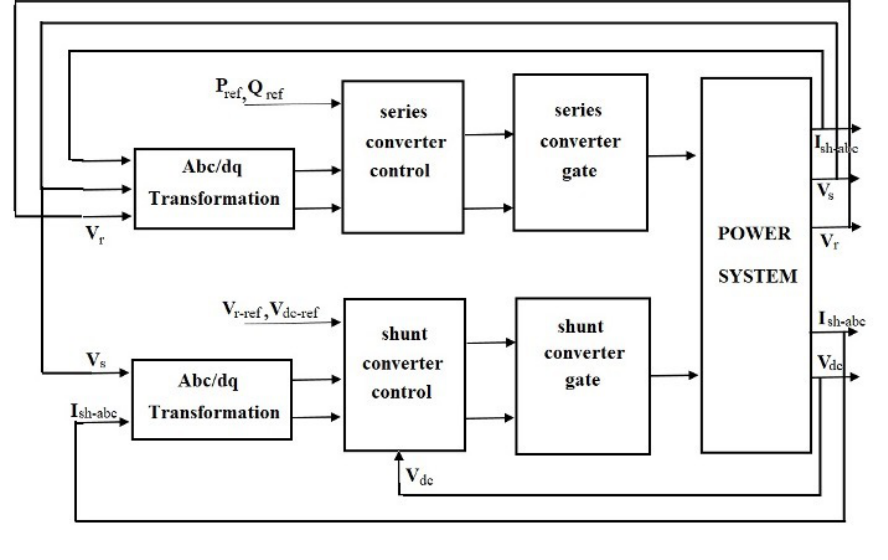
Figure 6. Overall Block Diagram of UPFC Control